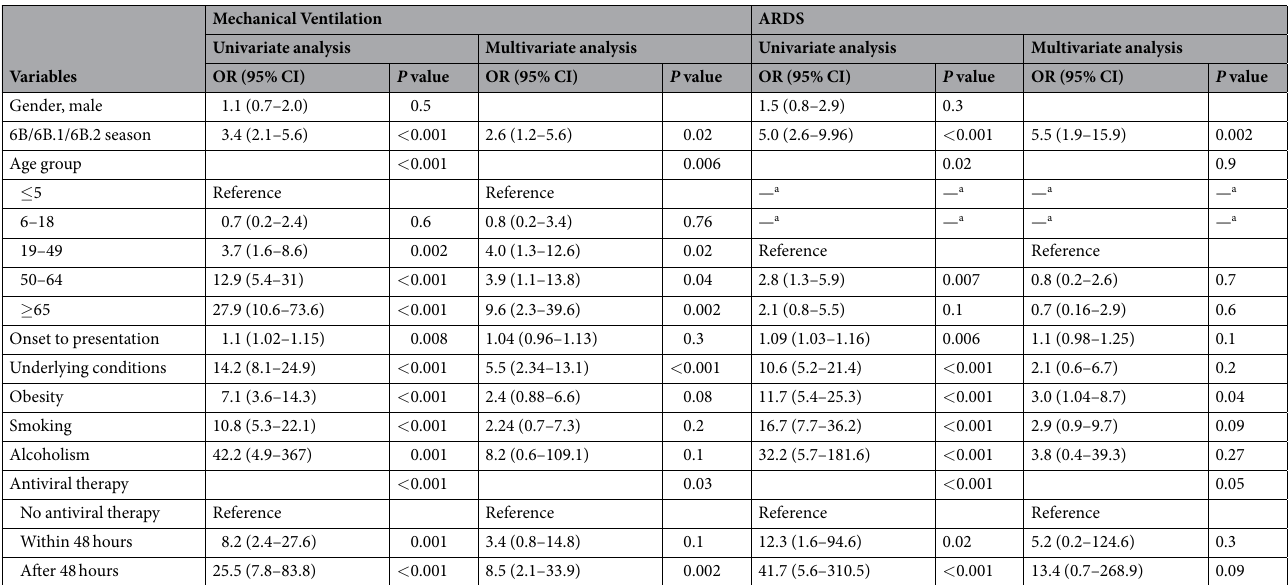
Table 5. Logistic Regression Analysis of the Risk Factors Associated with the Mechanical Complication and Acute Respiratory Distress Syndrome (ARDS) among Patients with Influenza A(H1N1)pdm09 Virus Infection. a Data cannot be calculated due to absence of ARDS in the age